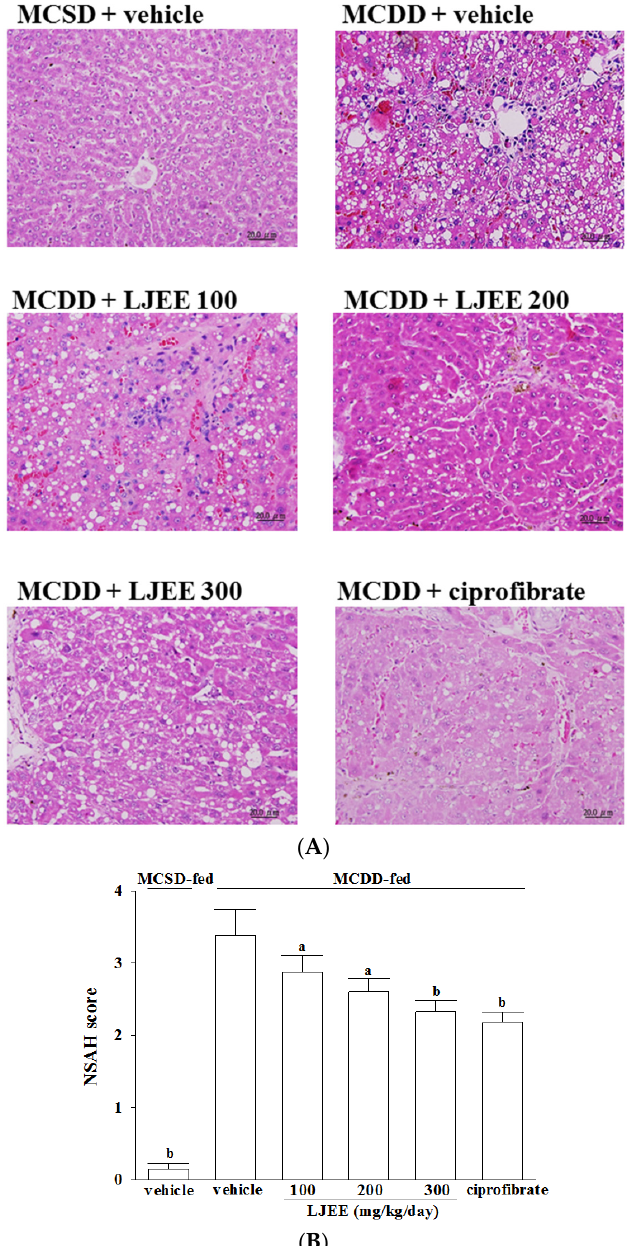
Figure 1. Effects of treatments on liver histology. ( A ) Representative images of hematoxylin and eosin stained livers from methionine ‐ and choline ‐ sufficient diet (MCSD) ‐ and methionine ‐ choline ‐ deficient diet (MCDD) ‐ fed mice after four weeks of LJEE or ciprofibrate treatment. The vehicle (distilled water) used to prepare the test medication solutions was given at the same volume. Photomicrographs (original magnification, 200×) of livers isolated from vehicle ‐ treated MCSD ‐ fed mice (MCSD + vehicle), vehicle ‐ treated MCDD ‐ fed mice (MCDD + vehicle), 100 mg/kg/day (MCDD + L. japonica ethanol extract (LJEE) 100), 200 mg/kg/day (MCDD + LJEE 200), and 300 mg/kg/day (MCDD + LJEE 300) LJEE ‐ treated MCDD ‐ fed mice. Another group of MCDD ‐ fed mice was orally administered 10 mg/kg/day of ciprofibrate (MCDD + ciprofibrate); ( B ) Sections were evaluated in a blinded manner by pathologists, and a scoring method was assigned as described in experimental methods for NASH evaluation. Values (mean ± standard deviation (SD)) were obtained from each group of eight animals. a p < 0.05 and b p < 0.01 compared to the values of vehicle ‐ treated MCDD ‐ fed mice in each group, respectively.